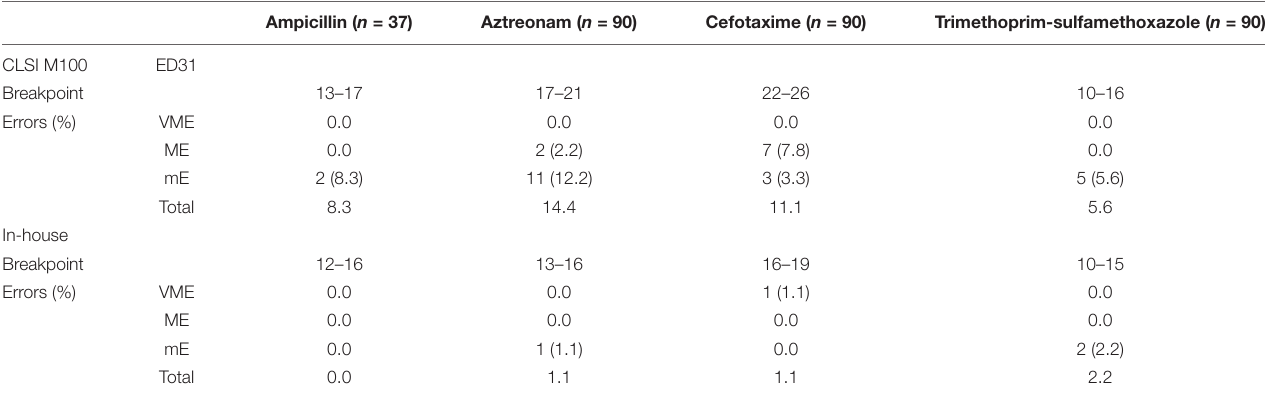
TABLE 4 | The categorical errors with rAST (18 h) between CLSI and in-house